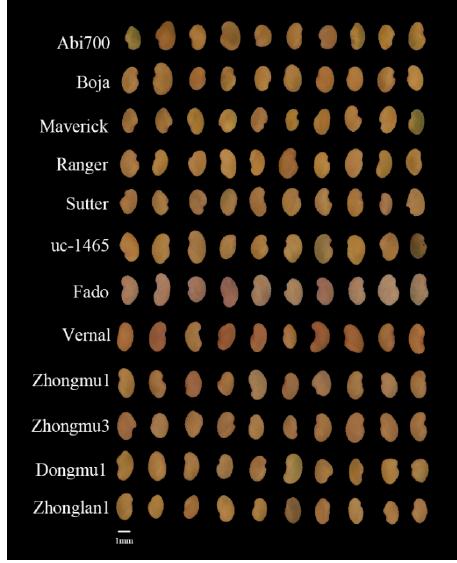
Figure 1. Seed image of 12 Medicago sativa L. cultivars.